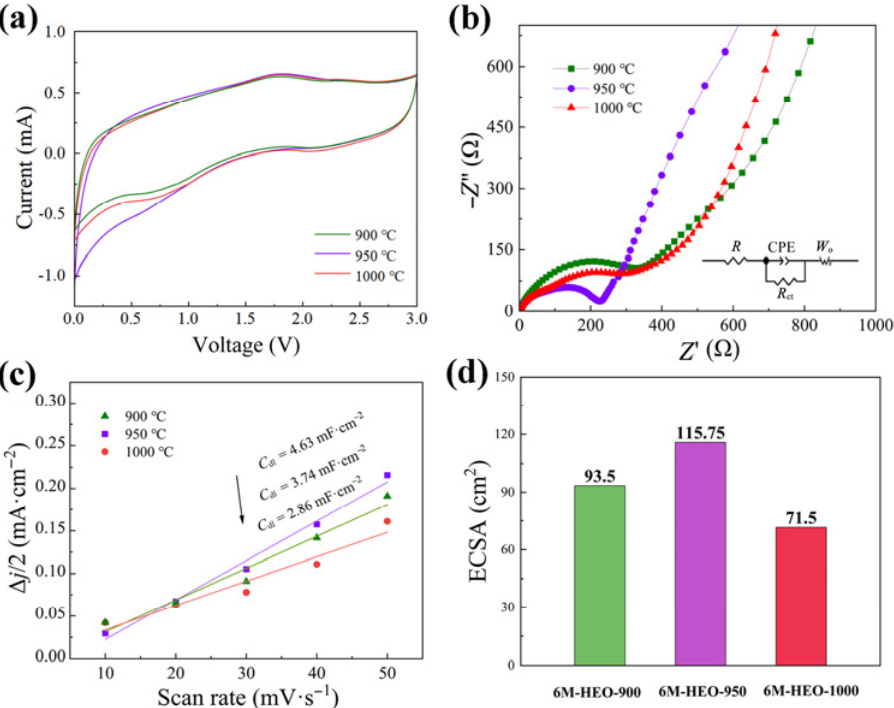
Fig. 6 Electrochemical performance of 6M-HEO-900, 6M-HEO-950, and 6M-HEO-1000 electrodes: (a) CV curves at 0.5 mV·s − 1 , (b) typical Nyquist plots (the inset shows corresponding equivalent circuit), (c) C dl fitting curves ( Δ j /2 is the intermediate value of current density), and (d) values of